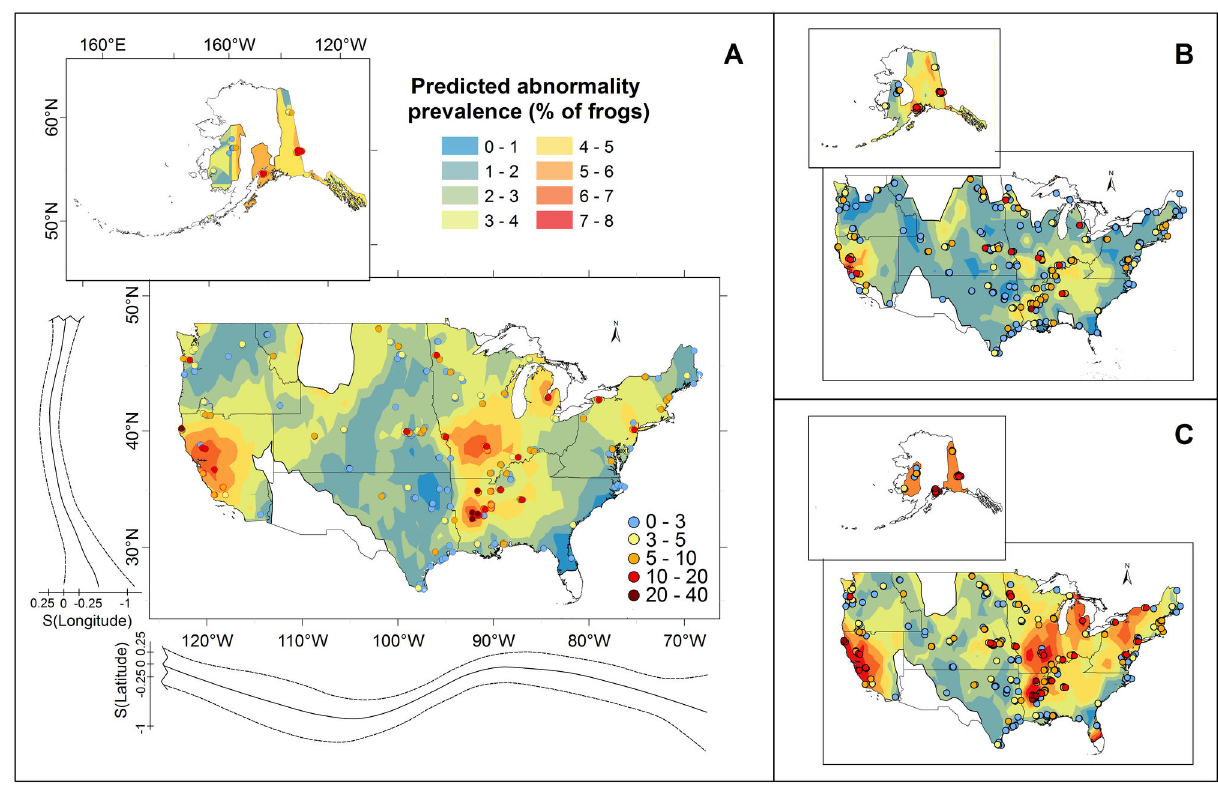
Figure 2. Geographic distribution of amphibian abnormalities with hotspot clusters. Warmer colors represent higher predicted abnormality prevalence (% of frogs abnormal). Sample sites (N=462) from the 10-year survey are shown as circles; sites in significant hotspot clusters with high abnormality prevalence are indicated by a red circle outline. White polygons mask areas with high standard error (>0.023 prevalence units; Figure S9). Abnormality prevalence corresponded to latitude and longitude in a non- linear fashion (Figure S1, Table S4), as shown by solid lines (and dashed 95% confidence intervals) outside the map of the continental United States (Text S1). (A) Shows sites color coded and surface interpolated using the mean abnormality prevalence at each site. (B) Shows site color coding and surface interpolation using the minimum values at each site. (C) Shows site color coding and surface interpolation using the maximum values at each